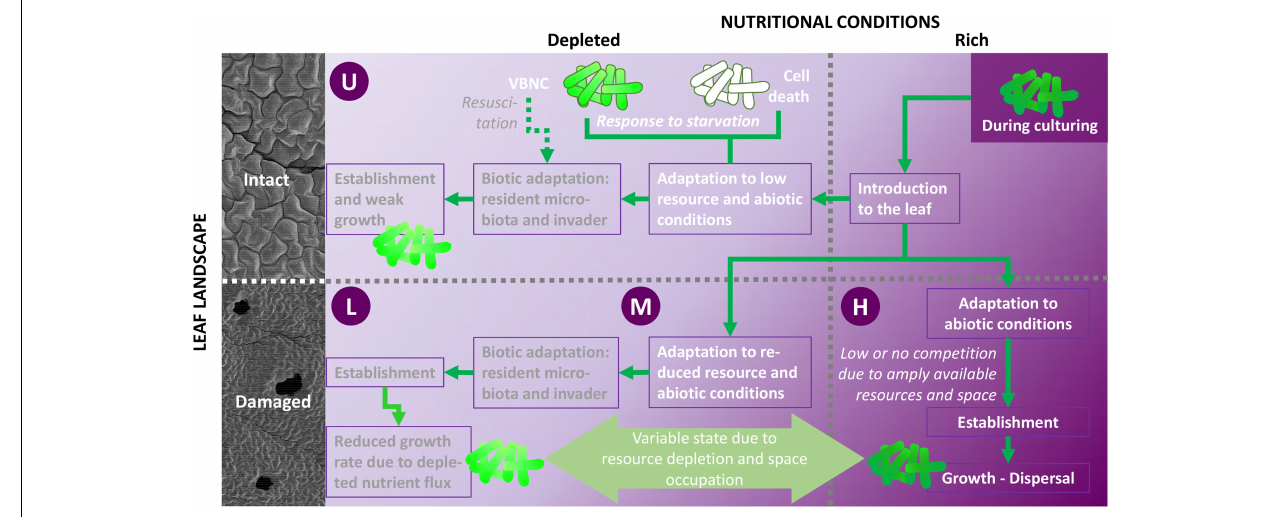
FIGURE 2 | Study conditions and potential processes following inoculation of E. coli O157:H7 gfp + on leaves with various damage levels (undamaged, U; low damage, L; moderate damage, M; high damage, H). Leaf injury (bruising) modifies both leaf landscape (removal of abiotic barriers, e.g., cuticle; 3D-extension of surface area to colonize, see also Figure 5 , Supplementary Figures 5–7 , and Supplementary Videos 1, 2 ) and the pool of readily available nutrients. The nutrient pulse exhibited through bruising (M) alleviates biotic competition for space and nutrients, allowing E. coli to maintain a well-functioning metabolism, to substantially grow (dark green cell shade), and to disperse. In comparison, leaf landscape and resource pool alterations are less pronounced in low- and medium-damaged leaves, leaving E. coli to cope to with varying degrees of abiotic and biotic hurdles, leading to reduced growth rates due to depleted nutrient flux (medium green cells). Resource availability in damaged leaves varies over time. Wounds may not be viewed as a static culture. The nutrient pulse due to high damage is most pronounced directly after wounding, leading to resource utilization and concomitant decreases in growth rates during days after wounding. Under low and moderate damage, cells may be excited by a secondary nutrient pulse due to decaying leaf tissue. This, together with resuscitation of metabolically compromised cells, allows high growth rates. Thus, growth response of E. coli to leaf damage is dependent on the resource phase. Nutrient scarcity (U, L) leads to cell death (open cells with dark green frame) or loss of culturability (viable but not culturable, VBNC; light green cells with dark green frame). Cells may resuscitate from the latter when nutrient availability increases. Thus, reluctant E. coli growth is expected under such conditions (Illustration: B. Alsanius ; SEM photos: E. Mulaosmanovic